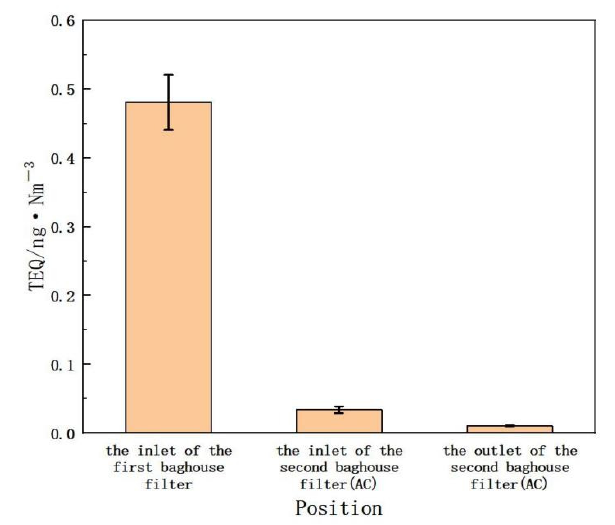
Figure 5. PCDD/Fs concentrations the inlet of the first baghouse filter, the inlet and outlet of the second baghouse with activated carbon injection.